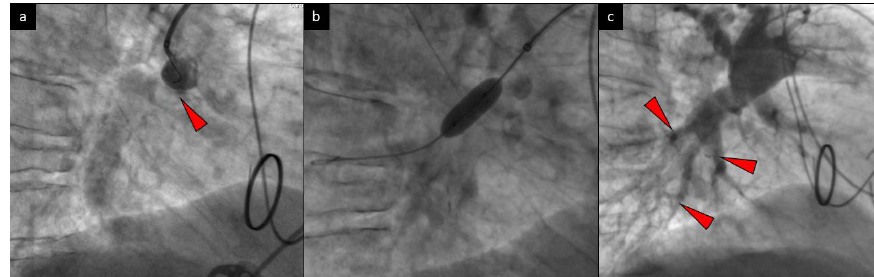
Figure 2. Selective angiography of the right pulmonary artery presents a subtotal occlusion (arrow) of segments A9 and A10 ( a ) and BPA of the lesion with a 7.0 mm balloon catheter ( b ). Control angiography with the improvement of distal perfusion (arrows) is shown ( c ).